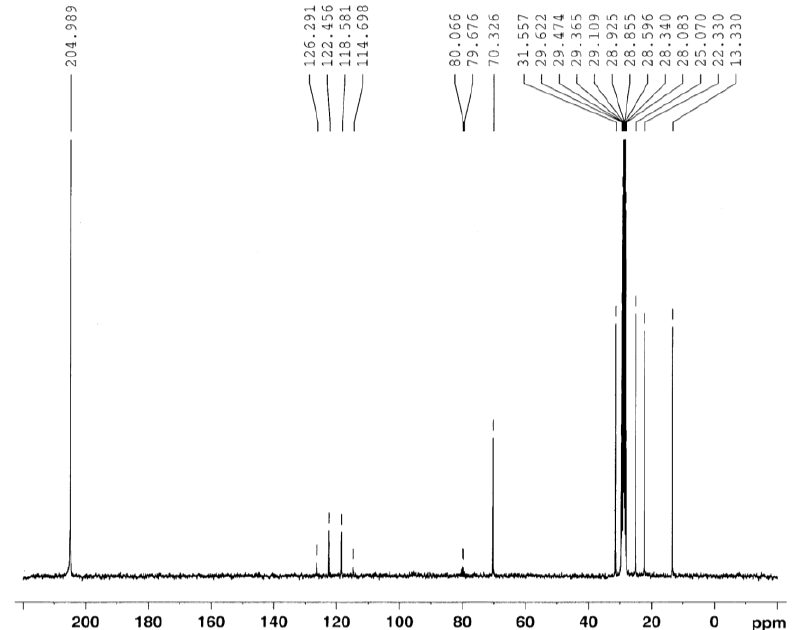
Figure S2. 13 C NMR of C8-PFTE at 75.6 MHz. d6-Acetone set at 204.99 ppm is the